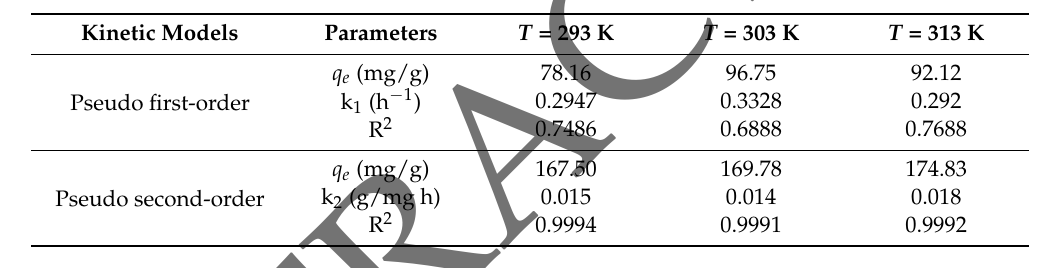
Figure 5. Adsorption kinetics of Zn(II) on GO ( C 0 = 25 mg/L, m/v = 0.12 g/L, I = 0.01 mol/L NaClO 4 , T = 293 K). Table 3. Kinetic parameters of Zn(II) adsorption on GO.